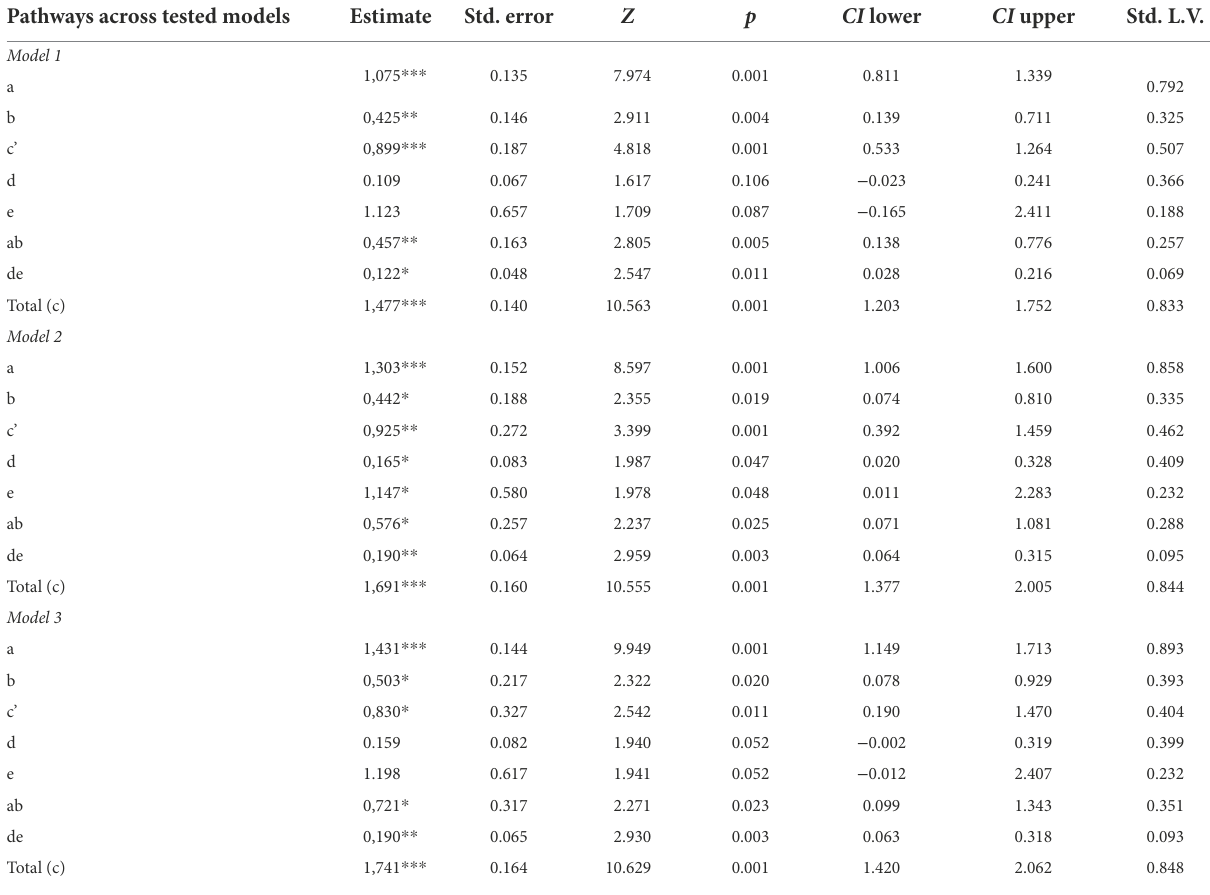
TABLE 4 Positive identity double-mediation estimated paths through SEM in Chilean youth. Pathways across tested